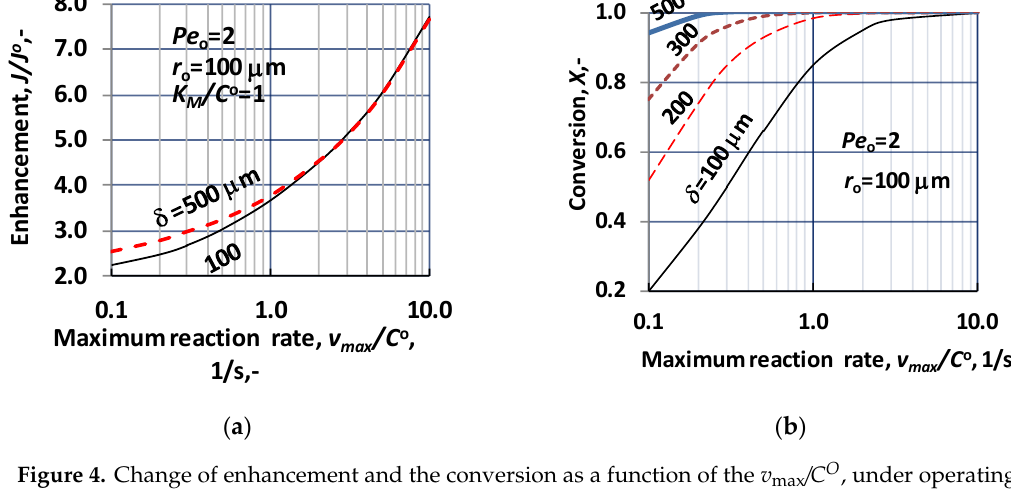
Figure 4. Change of enhancement and the conversion as a function of the v max /C O , under operating mode without sweeping phase, i.e., d C /d R = 0 at R = R m , applying the Michaelis–Menten kinetics ( N = 1000). ( a ) Change of the enhancement as a function of the reaction rate, more exactly as a function of v max /C O , at different values of the biocatalytic membrane thickness ( Pe o = 2; r o = 100 μm; K M /C O = 1); ( b ) change of the conversion grade as a function of the reaction rate ( Pe o = 2; r o = 100 μm; K M /C O = 1).